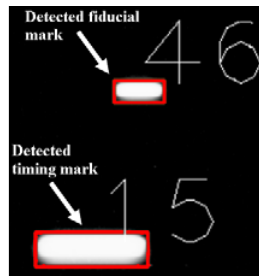
Figure 8: Automatically detected fiducial and